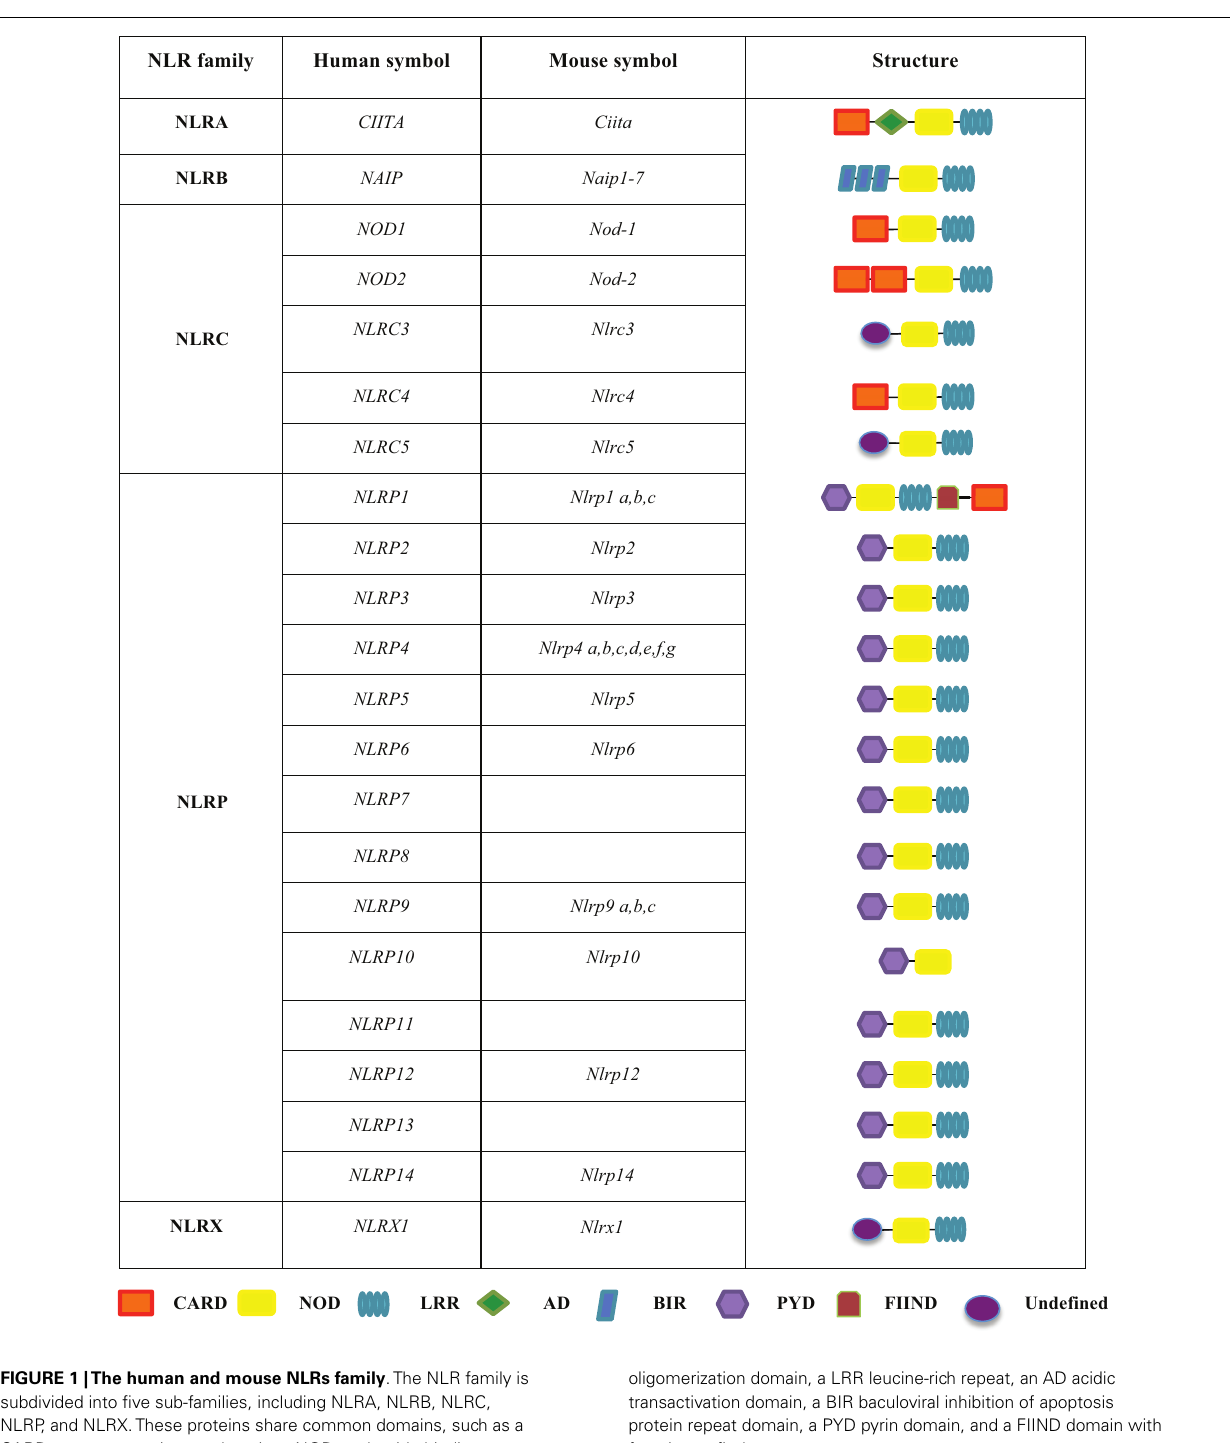
oligomerization domain, a LRR leucine-rich repeat, an AD acidic transactivation domain, a BIR baculoviral inhibition of apoptosis protein repeat domain, a PYD pyrin domain, and a FIIND domain with function to